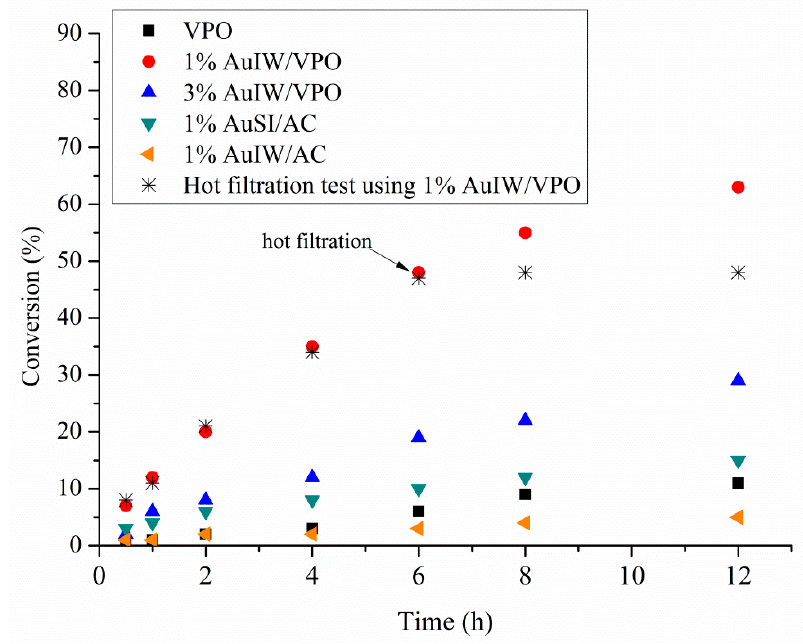
Figure 1. Reaction profile of un-promoted and promoted VPO catalysts with Au in the benzyl alcohol oxidation.